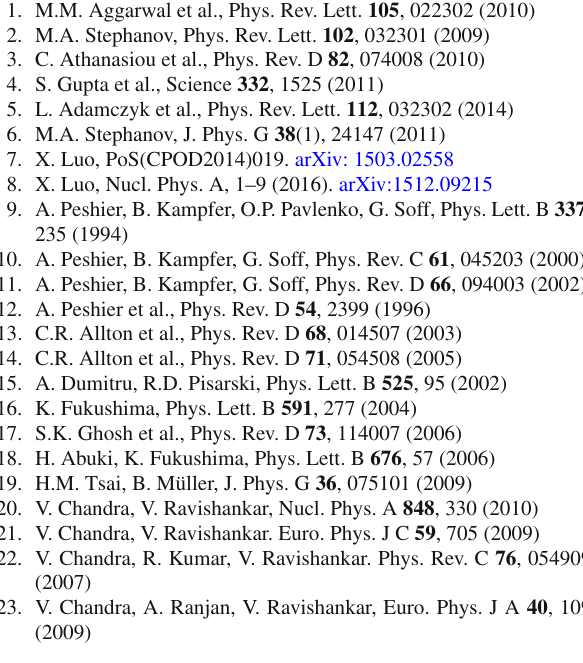
Fig. 5 The top three lines are κσ 2 results from Eq. (12) as a function of lines are κσ 2 for (cid:10) T / T c = 0 . 7 , 0 . 63 , 0 . 57 at a = ( 1 /π) 2 . Data points from Ref. [7,8] are κσ 2 results of Au+Au collisions at different centrality